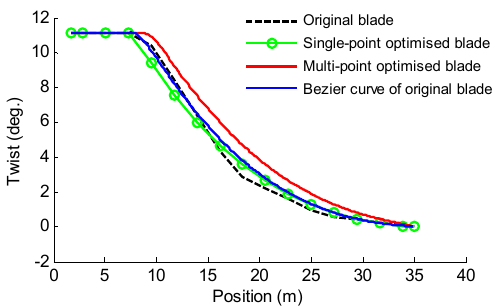
Figure 8. Chord distributions of the optimized and the original blades.